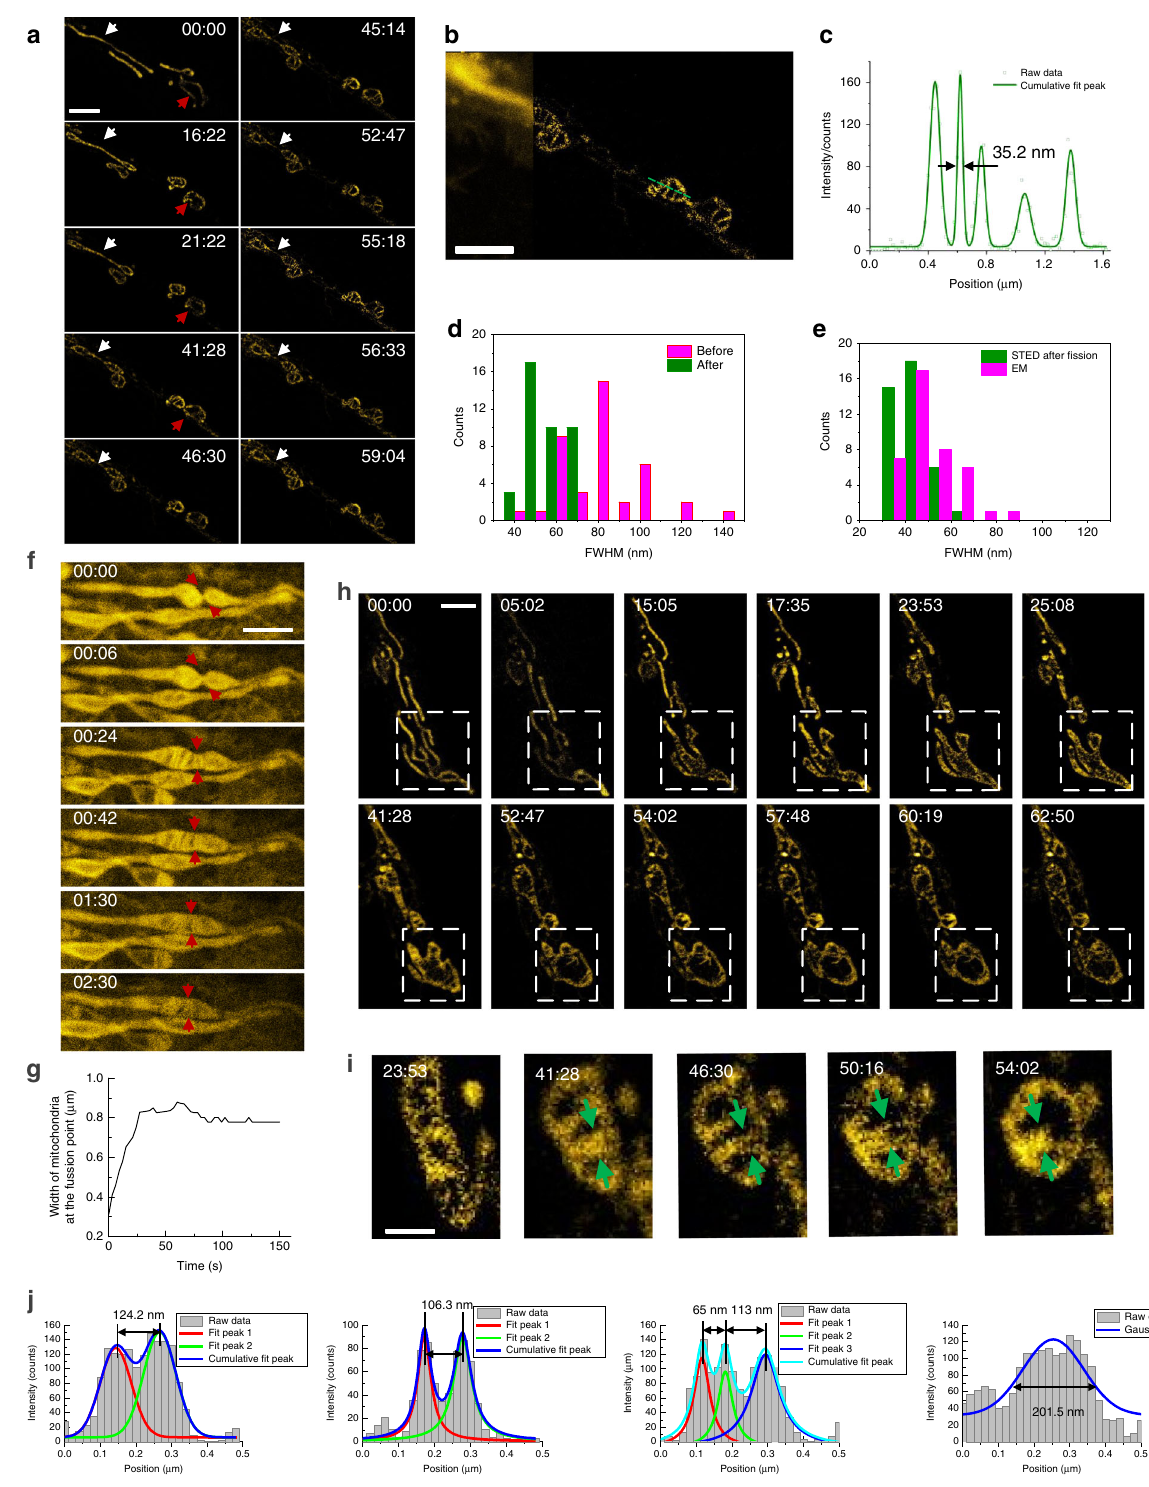
Fig. 4 Mitochondrial fi ssion and fusion process observed with STED optical nanoscopy. a Time-lapse STED imaging of mitochondria. The white and red arrows show typical mitochondrial fi ssion processes. b A comparison of confocal (left) and STED (right) imaging. The intensity pro fi le across the green dashed line in b is shown in c . A 35.2-nm resolution can be obtained from STED superresolution microscopy. d Distribution of cristae widths. Green bars: connective tubule width distribution histogram after fi ssion. Pink bars: tubule width distribution histogram before fi ssion. e Cristae width after fi ssion distribution histogram in STED and EM. f The red arrows show typical mitochondrial fusion processes, 3 s/frame. g The width of mitochondria changed with time at the fusion point in f , as indicated by the red arrows. It is 3 s per point, 51 points in total and illustrated by Origin software. h Quantitative images of mitochondria revealed cristae dynamics during fusion. i Cristae dynamics from a line shape to a bubble shape. j The cross-section plot along the green arrows in i is shown. Scale bars in a , b , f , h and i are 2, 2, 2, 5 and 1 μ m,